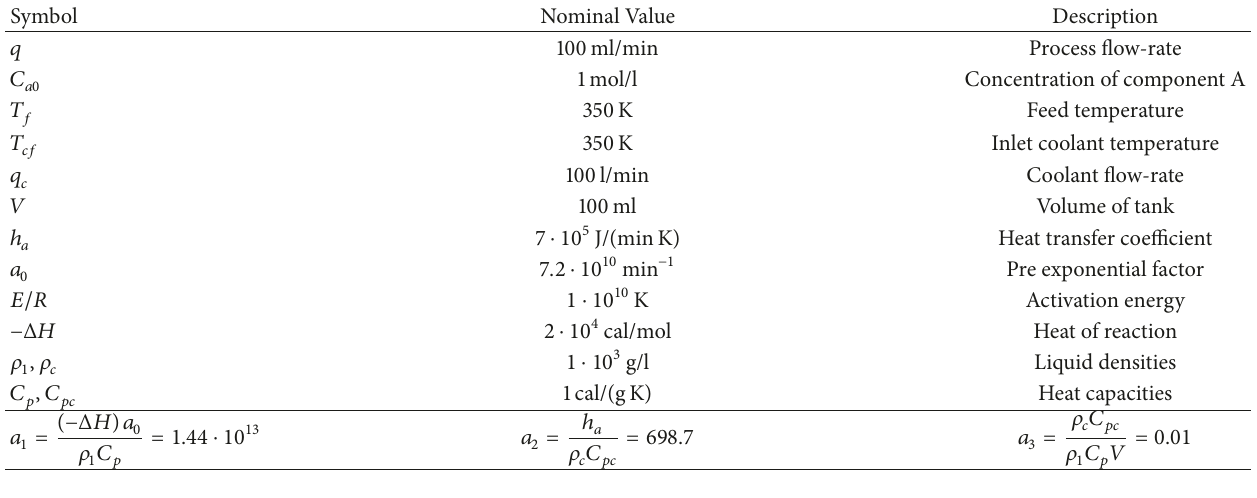
Table 1: Summary of parameters and variables in the CSTR model for Case 1.